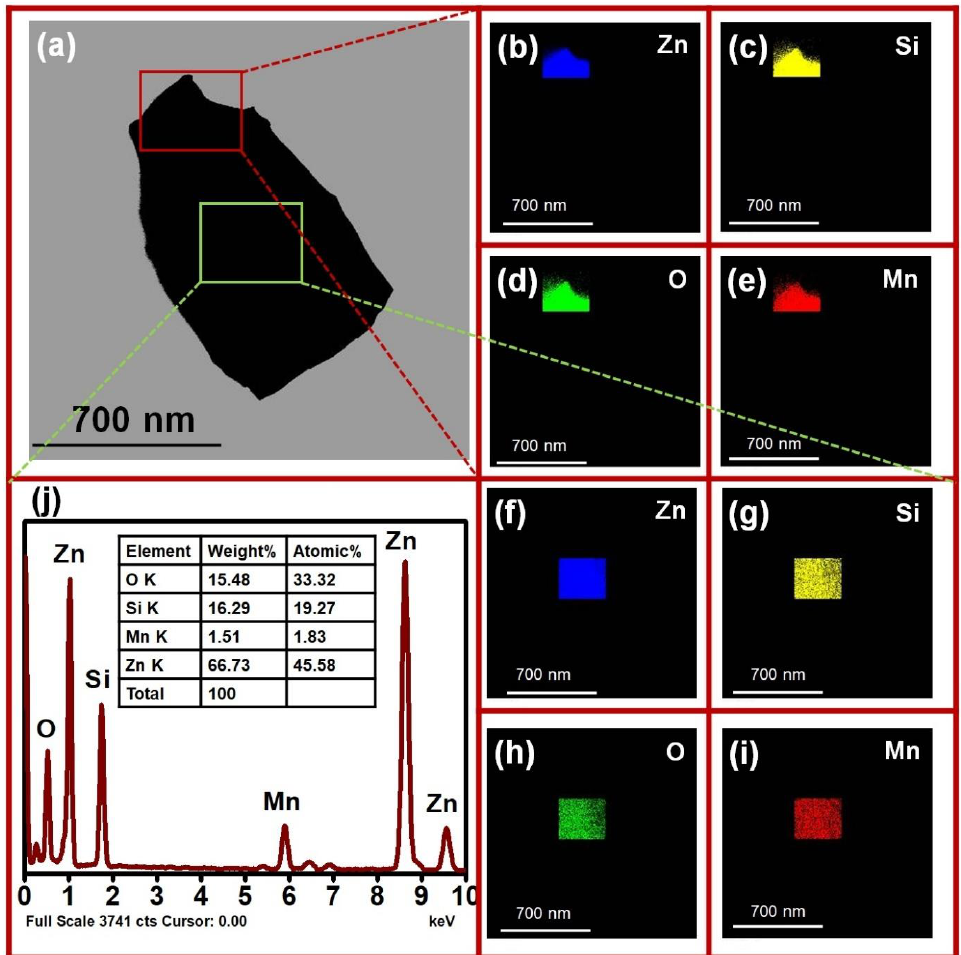
Figure 6. ( b – i ) show the spectra obtained from the EDS mapping of ( a ) which confirmed the Mn doping in Zn 2 SiO 4 lattice. ( j ) shows the quantitative analysis was also carried out to estimate the weight and atomic percentage of samples and EDS spectra.